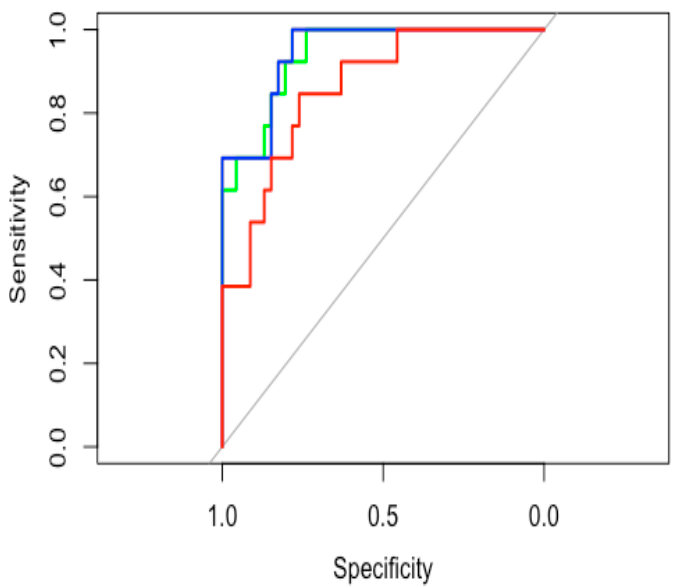
Figure 3. Glioma grading AUC values for the model predictions. Diffusion metrics from the DKI values were used to create model predictions of having a pLGG or a pHGG. ROC tests of the esti- mated probabilities of the DTI (red curve), DKI (green curve), and combined (DKI + DTI, blue curve) predictive model yielded AUC values of 0.859 (95%CI: 0.752–0.966), 0.939 (95%CI: 0.879–1), and 0.946 (95%CI: 0.889–1), respectively. pHGG: pediatric high-grade gliomas; pLGG: pediatric low- grade gliomas; DKI: diffusion kurtosis imaging.